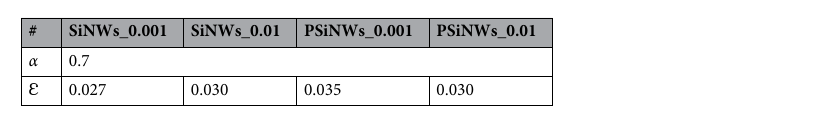
Table 1. Multiplying factor ( α ) and error ( Ɛ ) for various sintered NWs